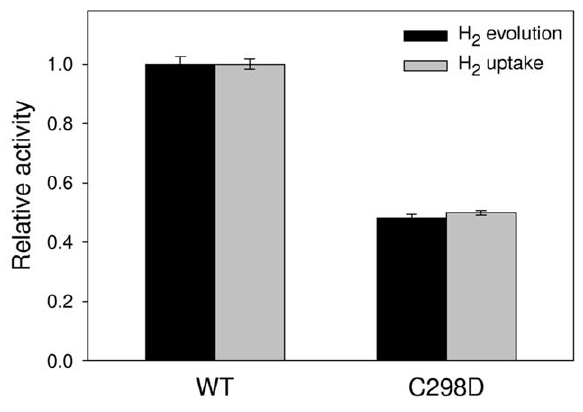
Figure 5. Hydrogenase activity assays. Enzymatic activity was assayed both in the direction of hydrogen evolution and hydrogen uptake at pH 8.0 with 10 mM methyl viologen as electron mediator, showing that C298D causes an equal decrease in the reaction rate for both reactions. Relative activity was calculated as the ratio with wild type activity (H 2 evolution: 230 6 6 m mol H 2 min 2 1 mg protein 2 1 ; H 2 uptake: 433 6 7 m mol H 2 min 2 1 mg protein 2 1 ).